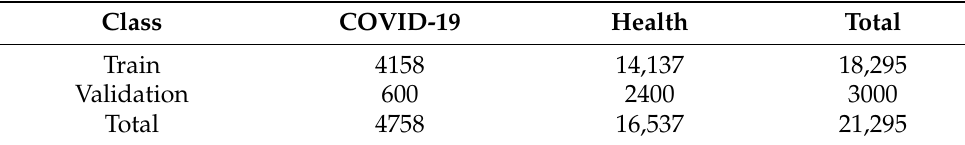
Table 3. Arrangements of the synthetic-covid-cxr dataset.